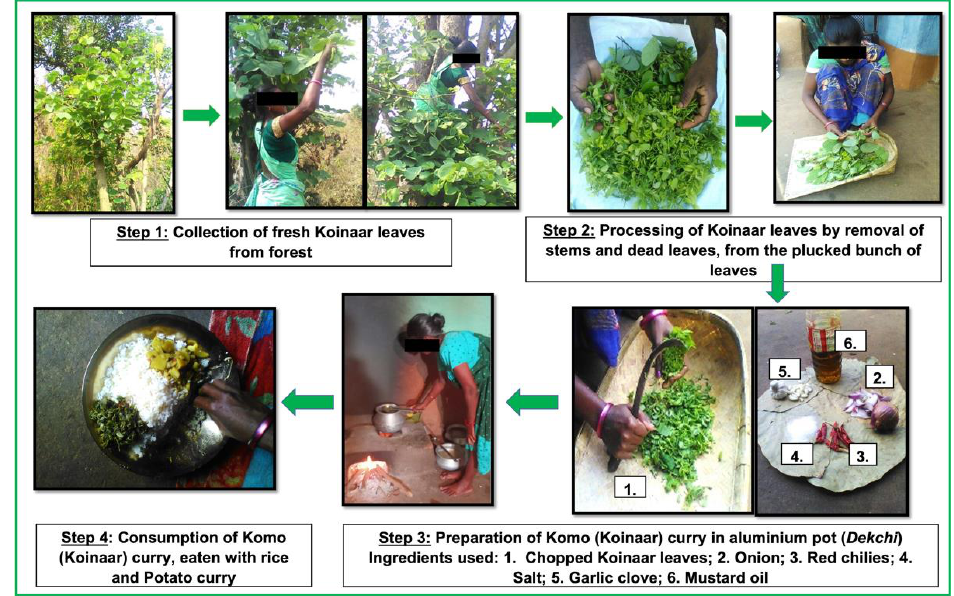
Figure 5. The different steps in the value chain of Koinaar leaves in Godda district, Jharkhand, India.